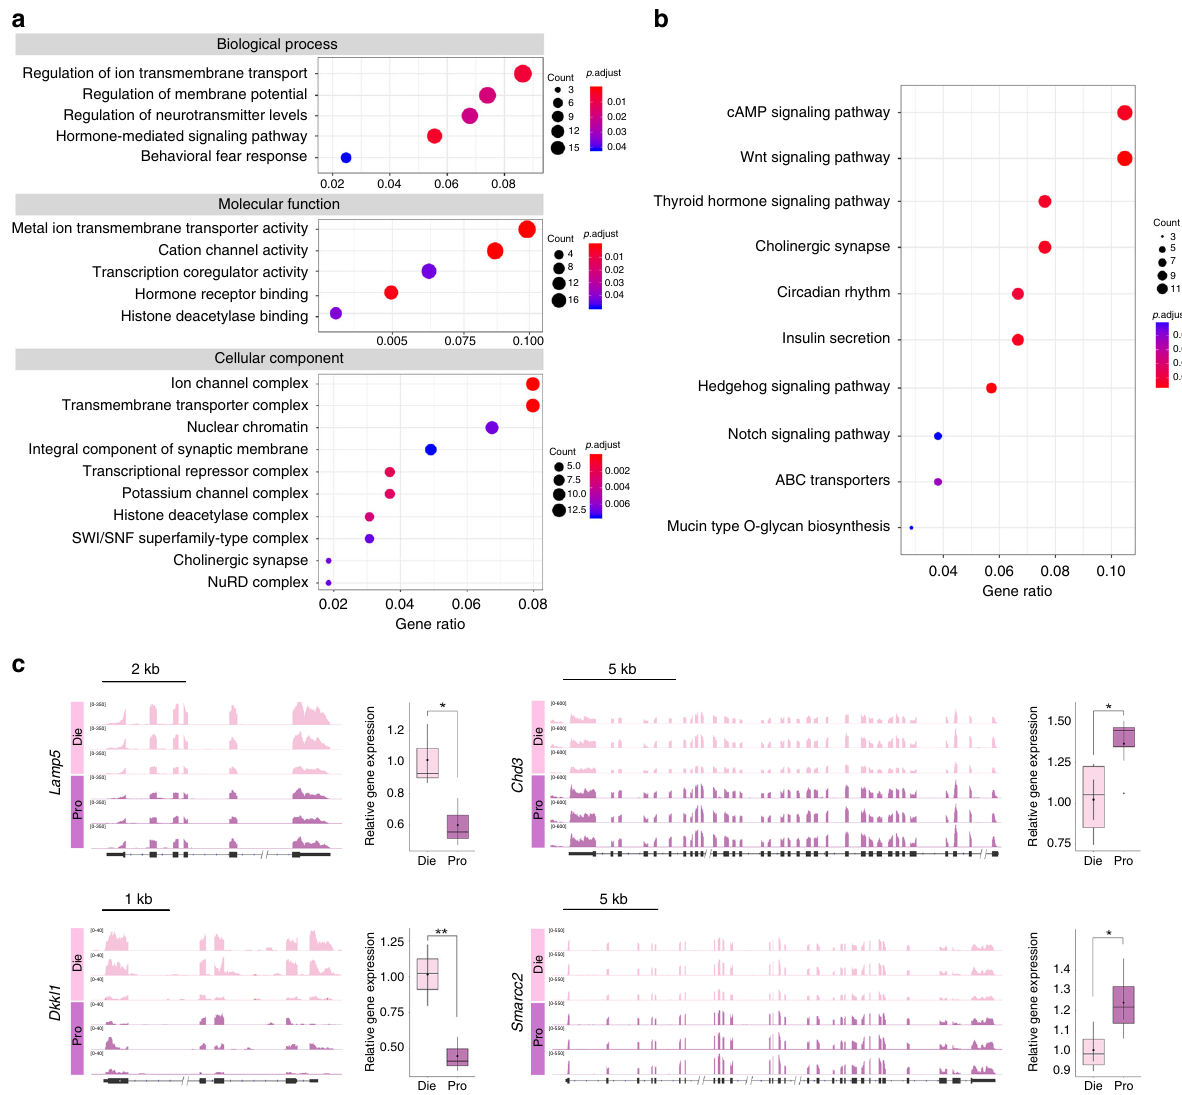
Fig. 4 Nuclear RNA expression in ventral hippocampal neurons varies with the oestrous cycle. a GO analysis of genes showing differential nucRNA expression between dioestrus and proestrus (selected GO terms for biological process, molecular function, and cellular component are shown); the horizontal axis represents gene ratio, colours indicate adjusted p- values and dot size corresponds to gene count. b KEGG analysis of genes showing differential nucRNA expression between dioestrus and proestrus (ten selected pathways are shown); c nucRNA expression pro fi les of candidate genes Lamp5 , Dkkl1 , Chd3 and Smarcc2 showing differential expression between dioestrus and proestrus (shown are IGV tracks of nucRNA-seq data and corresponding box plots showing results of qPCR validation). ( n = 3 biological replicates/group); boxplots (box, 1st – 3rd quartile; horizontal line, median; whiskers, min/max; inner circles, mean ± SEM); * p < 0.05; ** p < 0.01 (unpaired t test, one-tailed). Die (light pink), dioestrus; Pro (purple),